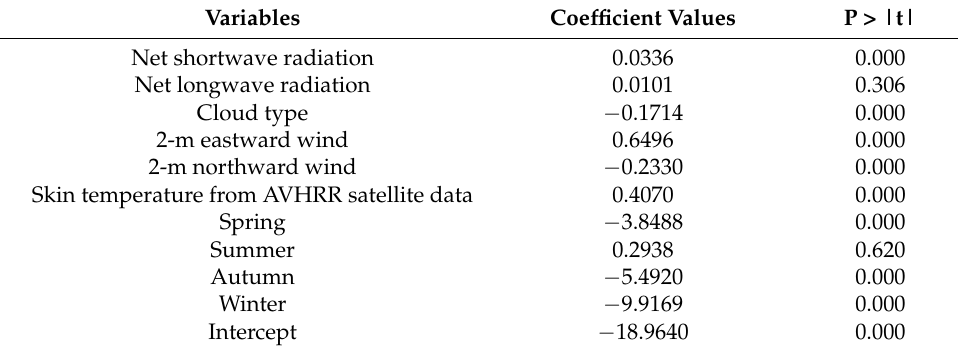
Figure 4. The seasonal distribution of the temperature differences. Table 3. The information of each parameter in linear